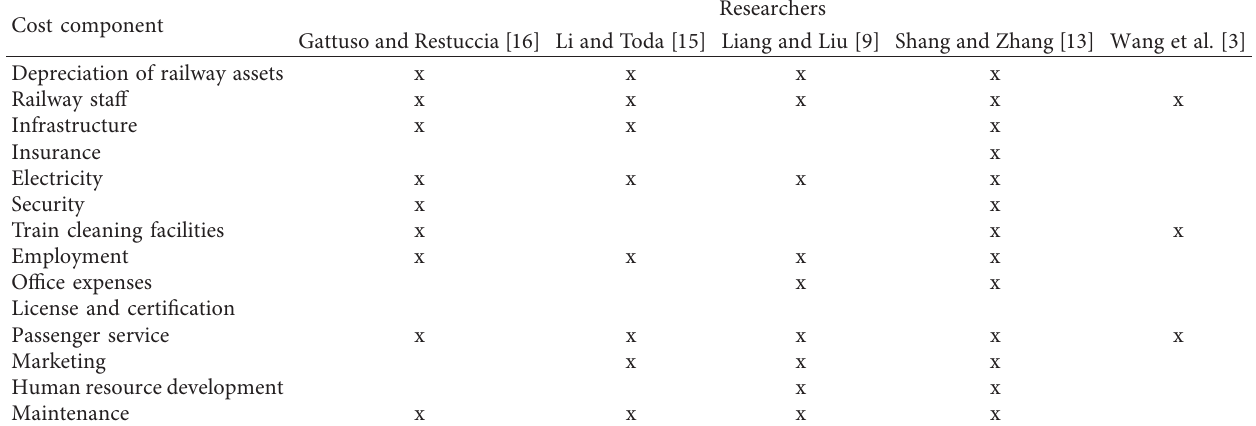
Table 1: Mapping of OM cost